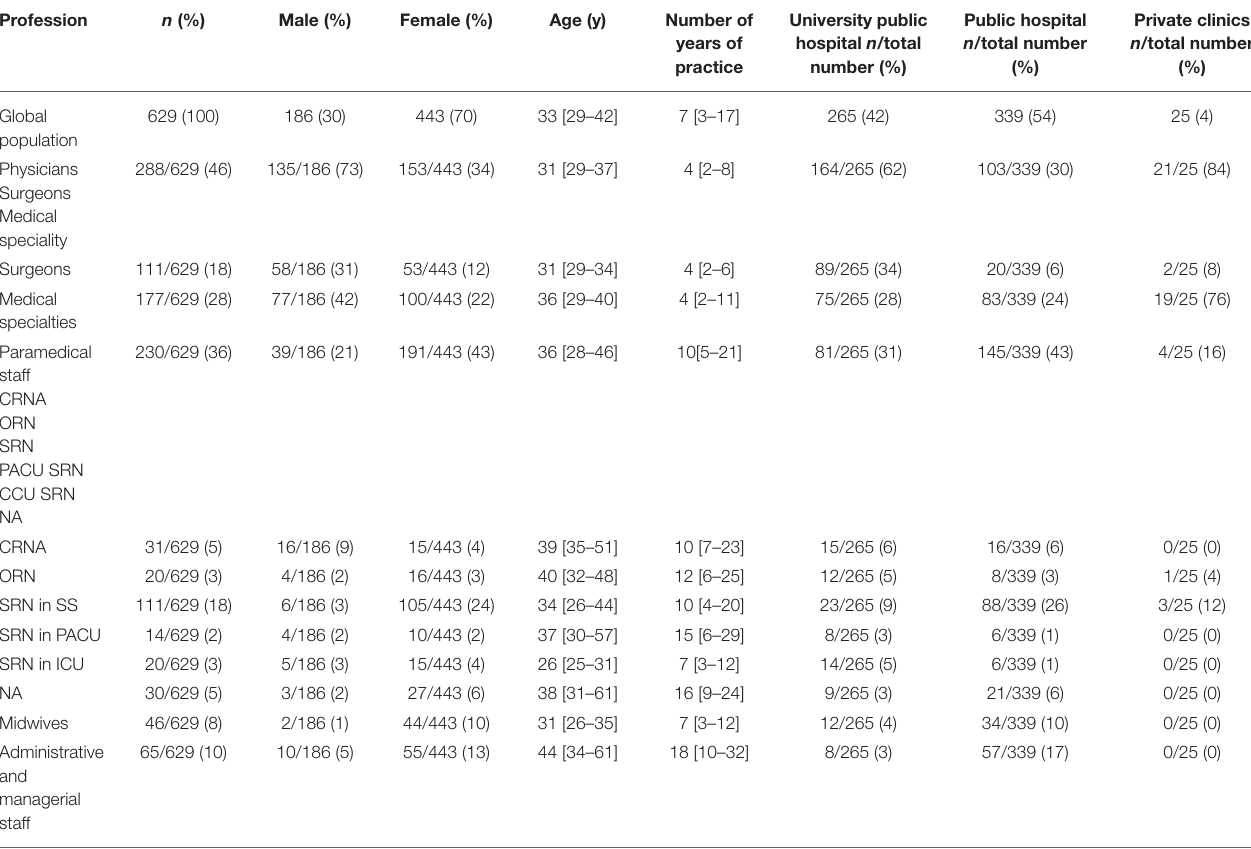
TABLE 1 | Baseline characteristics of the